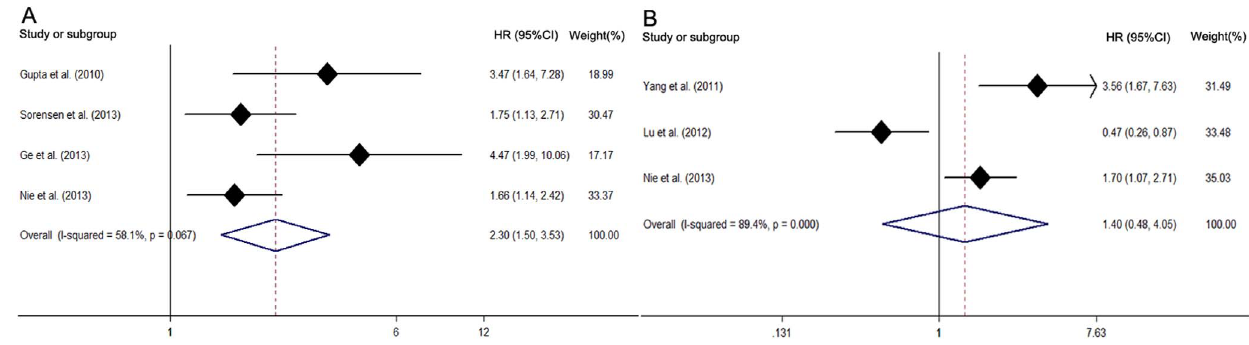
Figure 4. (A) Meta analysis of pooled hazard ratios of RFS of cancer with increased HOTAIR expression. (B) Meta analysis of pooled hazard ratios of MFS of cancer with increased HOTAIR